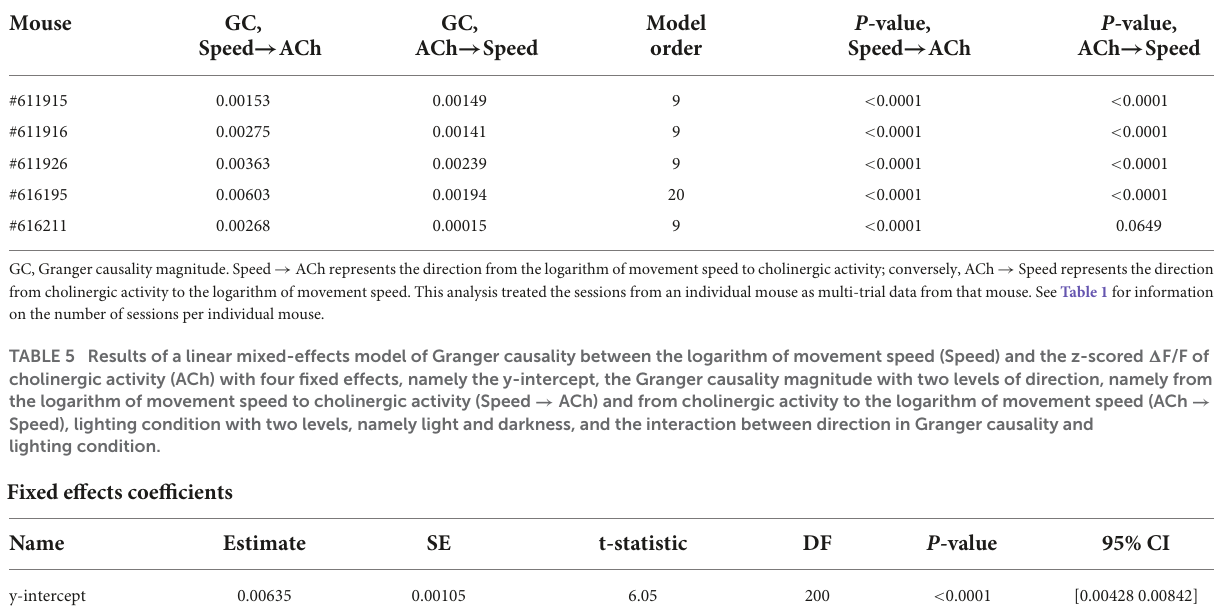
TABLE 4 Results of Granger causality analysis between the logarithm of movement speed and the fiber photometry signal (as z-scored (cid:49) F/F) of cholinergic activity in the MSDB.